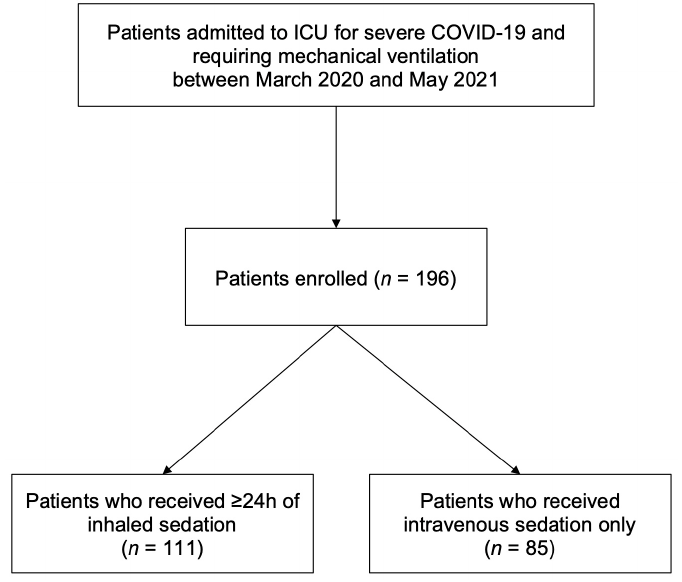
Figure 1. Flowchart of the study. Table 1. Baseline demographics, clinical and biological